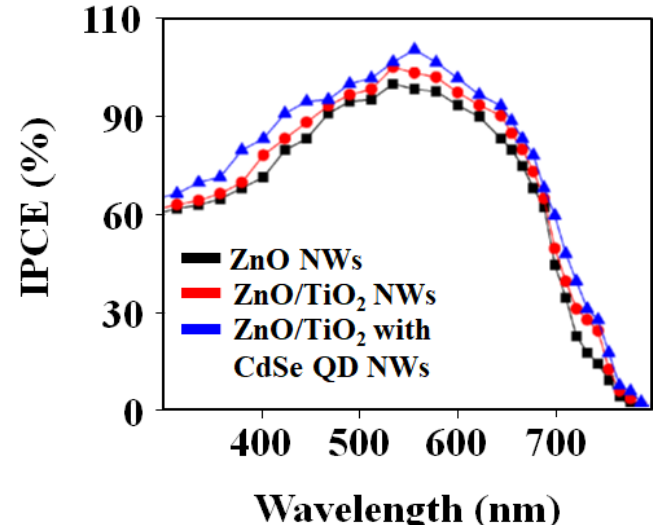
Figure 3. Normalized incident photon conversion efficiency (IPCE) spectra of the PSCs based on ZnO NWs without and with AgCl-doped CdSe quantum dots modification.